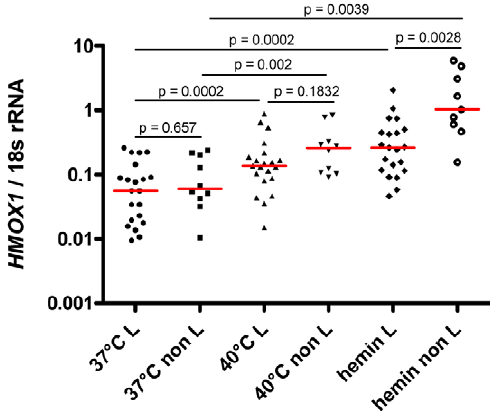
Figure 7. Higher HMOX1 mRNA induction in peripheral blood from ‘‘non-L allele’’ carriers in response to hemin. Induction of HMOX1 mRNA after 3 hrs exposure to 40 u C or 100 m M hemin is shown according to L/non L carrier status for 26 individuals, using blood collected on D28. The red line represents the median. Raw p values are reported. After Bonferroni’s adjustment for multiple comparisons the significance threshold becomes 0.007.